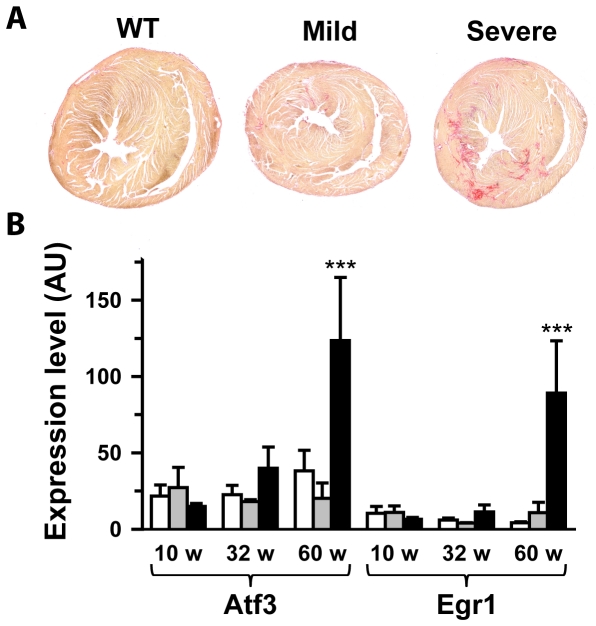
Variable levels of fibrosis in Scn5a
+/− mice.
A. Sirius red staining of ventricle from 85 week-old WT, mildly and severely affected Scn5a
+/− mice. Fibrosis appears in red. A score of 0 was attributed to the WT mouse shown, 1 to the mild Scn5a
+/− mouse and respectively 2 and 3 to left and right severe Scn5a
+/− mice. B.
Atf3 and Egr1 mRNA ventricular levels (in arbitrary units) in WT (open bars), mildly (grey bars) and severely (black bars) affected Scn5a
+/− mice as a function of age. ***, p<0.001 versus WT and mild.